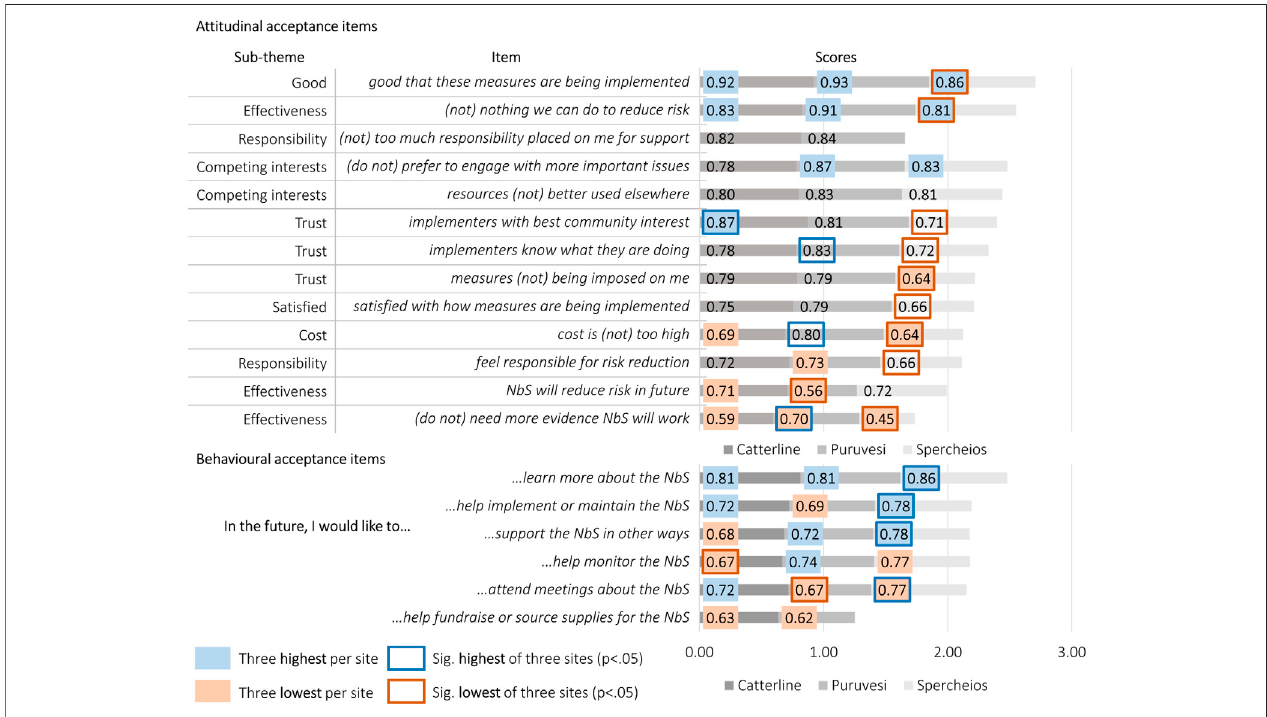
FIGURE 4 | Standardized average responses for survey items that represent attitudinal acceptance and behavioral acceptance in the three study sites. Response averagesarestandardizedbydividingbythemaximumLikertresponse(9forCatterlineandSpercheiosand7forPuruvesi),sothat1isthenewmaximumvalueand0the minimum. Attitudinal and behavioral items are ordered from top to bottom by highest sum of the average responses across the sites. The top three highest average responses for each site for each form of acceptance are highlighted in blue and the three lowest highlighted in red. Using Mann-Whitney U tests, the items that are signi fi cantly higher in one site compared to each of the other two sites ( p < 0.05) are outlined in blue and those signi fi cantly lower in red. The third attitudinal acceptance item from the top regarding responsibility and the last behavioral acceptance item were excluded from surveys conducted in Spercheios since they were not